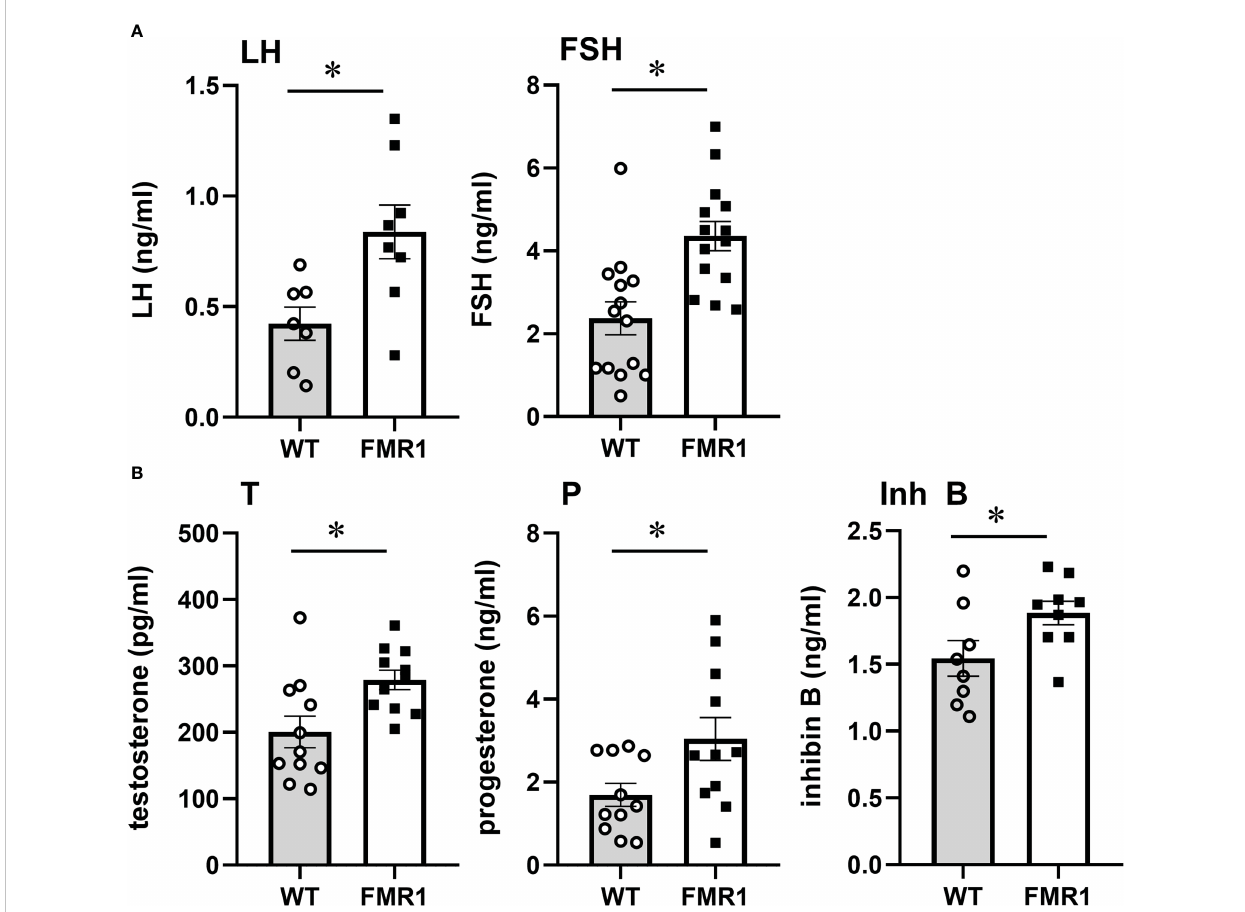
FIGURE 3 Fmr1 KO mice have higher LH and FSH. Serum levels of LH and FSH, (A) testosterone (T), progesterone (P) and inhibin B (Inh B) (B) in diestrus females in WT controls and Fmr1 KO. Each point represents one animal, while bars represent group means +/- standard error. LH was sampled from the tail tip after acclimatization to handling, to minimize stress and prevent exposure to iso fl urane that may affect LH levels. FSH, T, P, Inh B samples are obtained from inferior vena cava. Statistical signi fi cance, indicated with a * (p < 0.05) was determined with t-test followed by Tukey ’ s post hoc